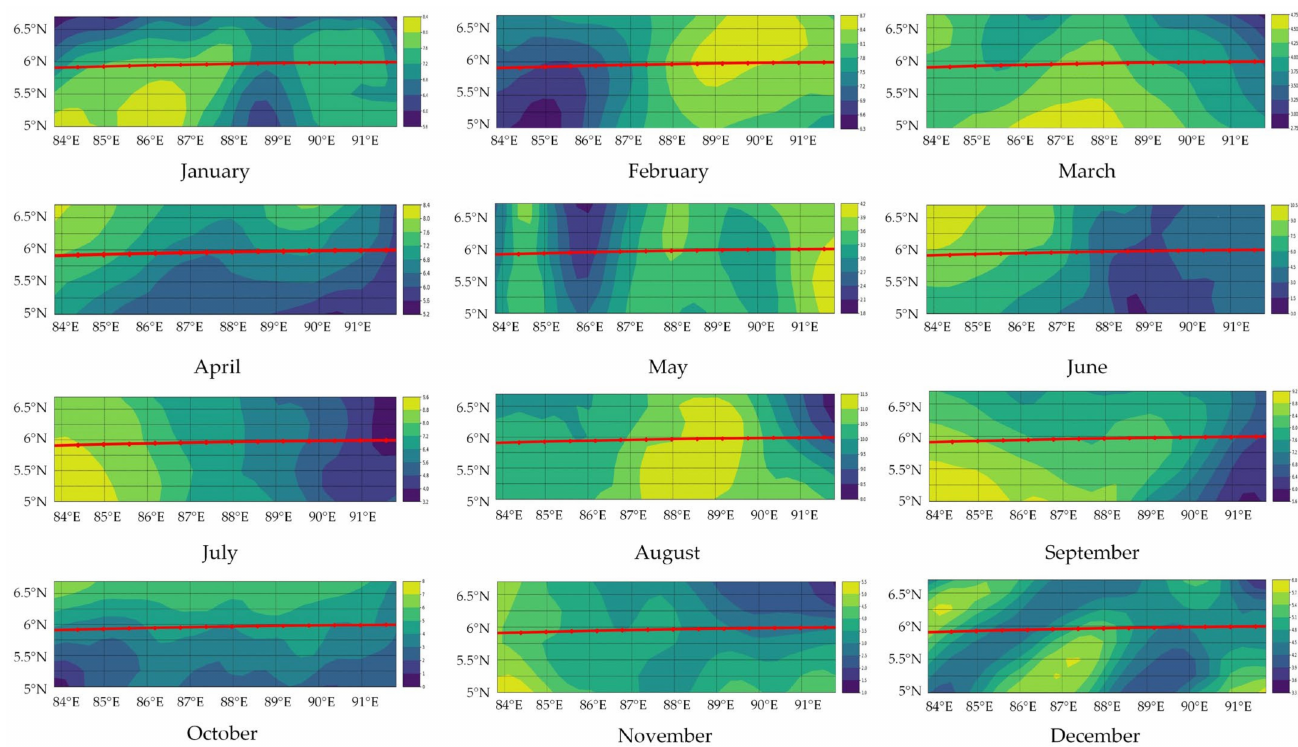
Figure 13. Spatial–temporal distribution characteristics of wind speed in Bay of Bengal.